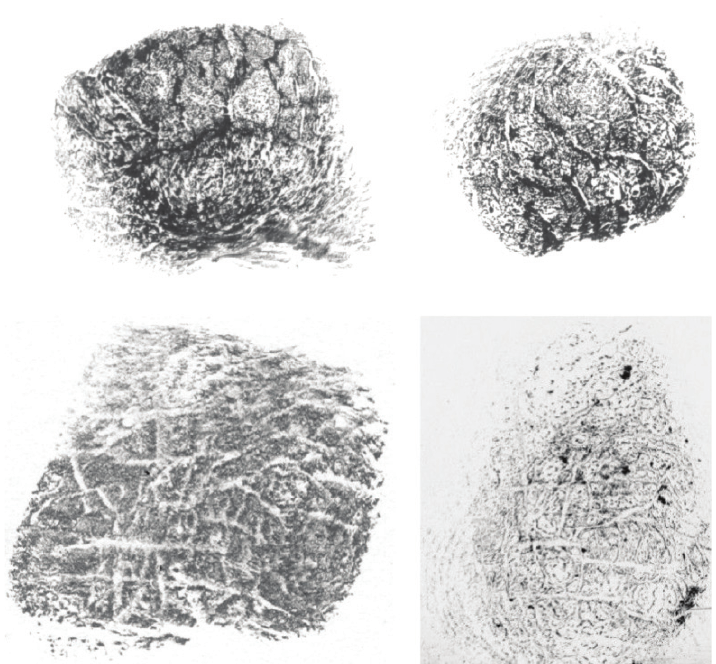
Figure 24: Fingerprints with advanced psoriasis (di ff erent